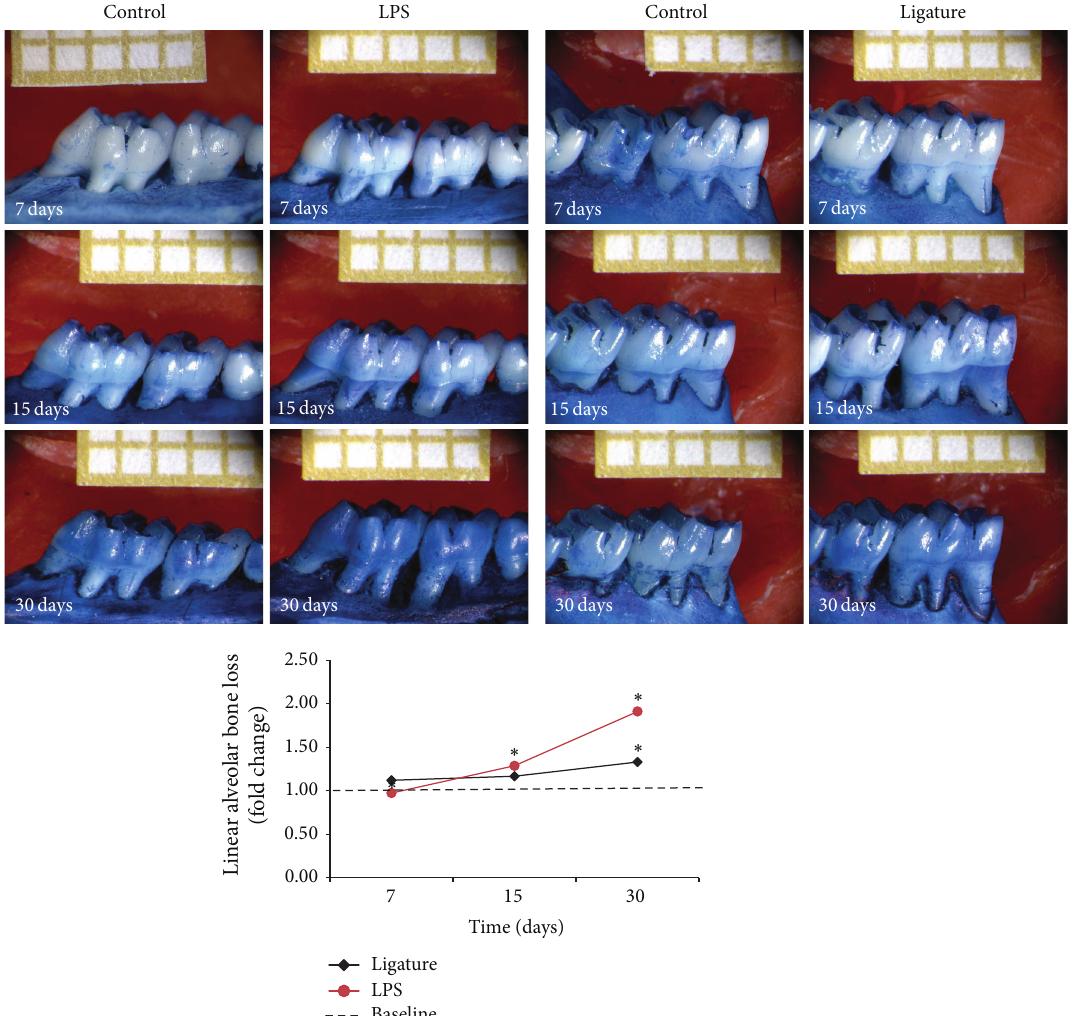
Figure 4: Linear alveolar bone loss was measured macroscopically in the lingual surface of the upper and lower first molars corresponding to LPS (left) and ligature (right) models, respectively. Representative samples stained with methylene blue for each group and period are shown. Graph with average ± standard deviation of linear alveolar bone loss in fold change. ∗ Significant difference among experimental periods ( 𝑃 < 0.05